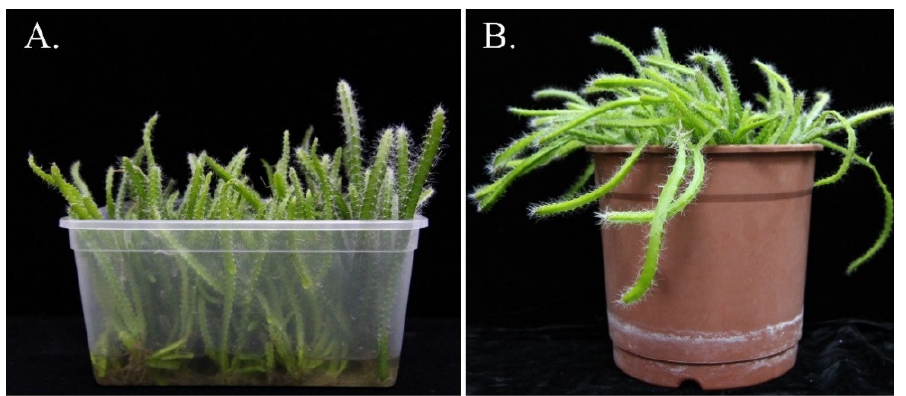
Figure 9. Acclimatization of Hylocereus polyrhizus ‘Da Hong’ at room temperature (22–25 °C). ( A ) Plantlets hardened by incubating in water, ( B ) all plantlets grew well at 4 weeks after transplanta- tion.